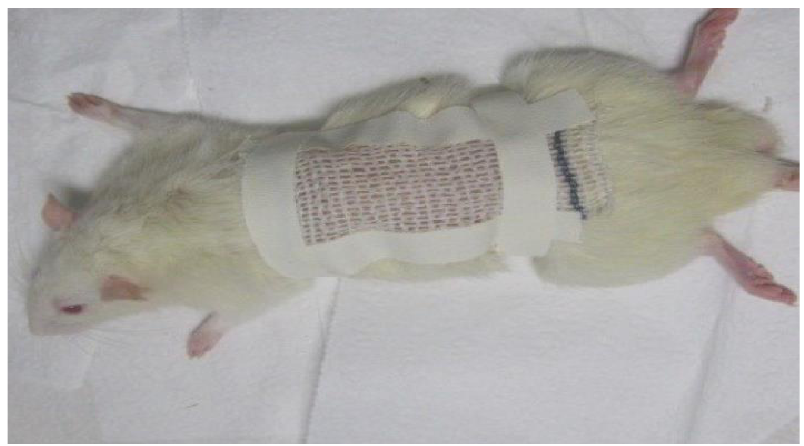
Figure 9. Animal after epilation, in treatment with hydrogel in acute dermal toxicity assay.